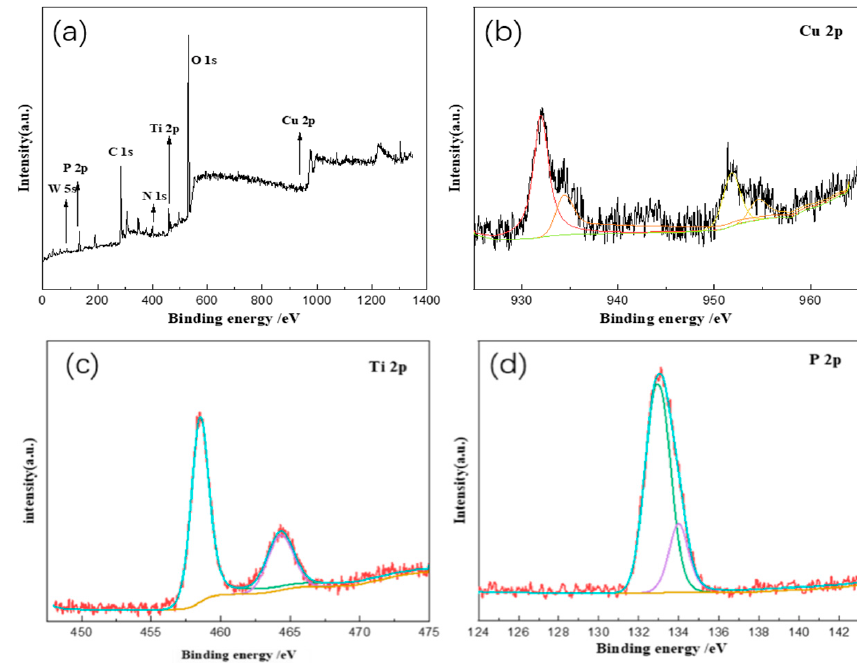
Figure 3. XPS spectra of MAO coating: ( a ) Survey; ( b ) Cu; ( c ) Ti; and ( d ) P.